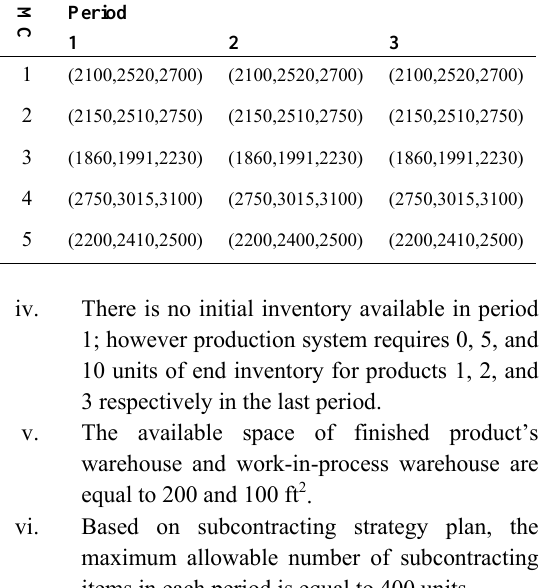
Table 2. Production data